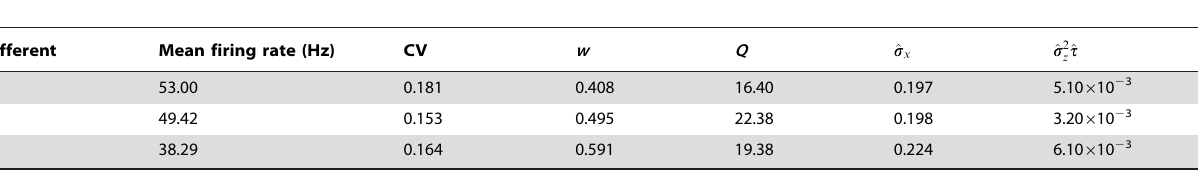
Table 1. Fitted values of PIF parameters for the three afferent neurons for which ISI statistics are shown in Fig. 7.